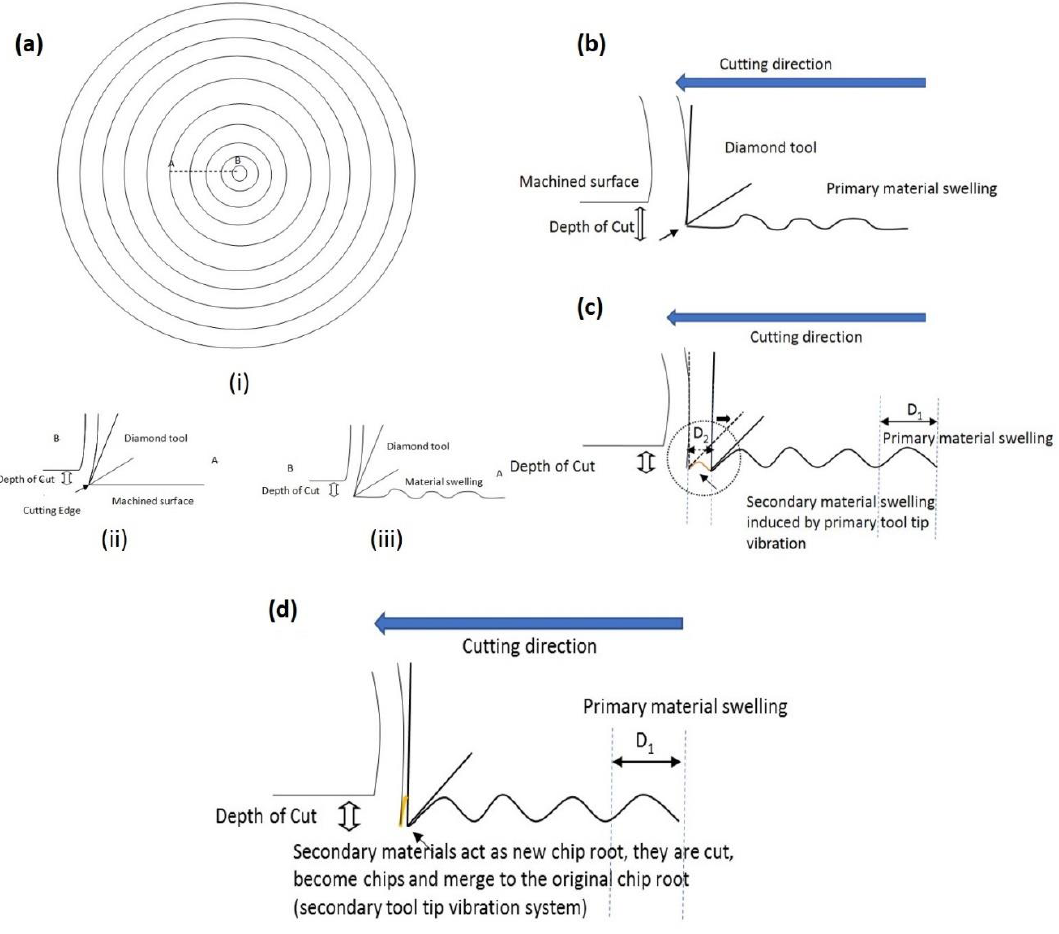
Figure 3. ( a ) The graphical illustration for material swelling generated in SPDT. ( b ) Primary material swelling (PMS) generated from the main turning motion. ( c ) SMS generated from the tool tip vibration. ( d ) The tool cuts the ragged materials of SMS and another tool tip vibration is generated.